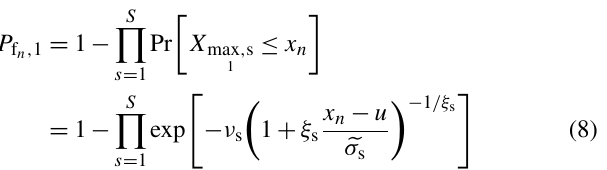
Figure 9. Failure regions in each section and their relation with the sectors of criteria T90 (a) , T45 (b) , and C0 (c)